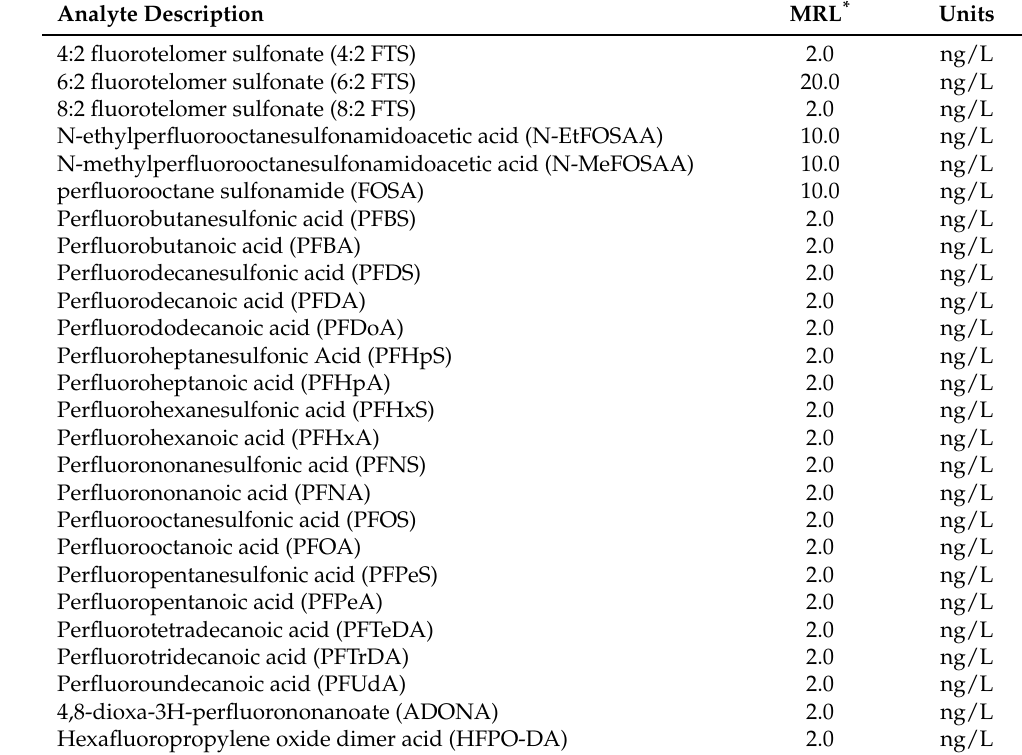
Table A4. Calibration standards used for PFAS detection. Analyte Description